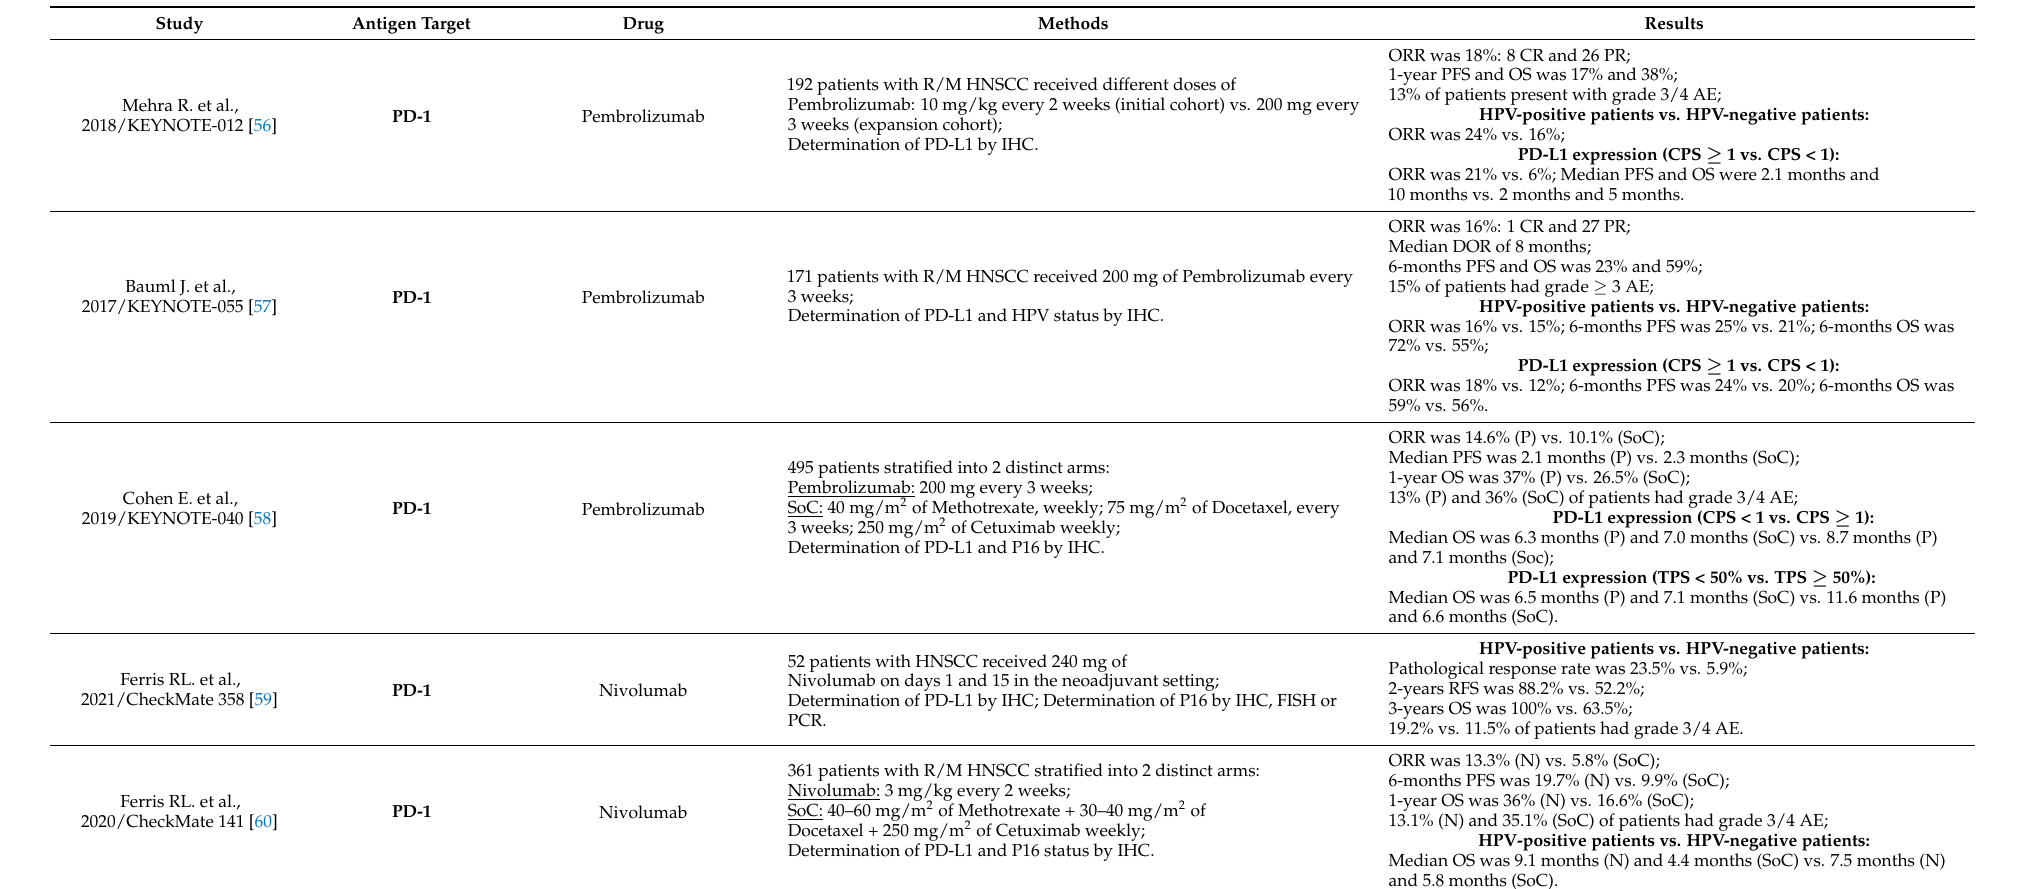
Table 2. Recent studies of immune checkpoint inhibitors, such as pembrolizumab, nivolumab, durvalumab, atezolizumab, avelumab, and monalizumab, as monotherapy, and their combinations with anti-CTLA-4 agents, chemotherapy, and